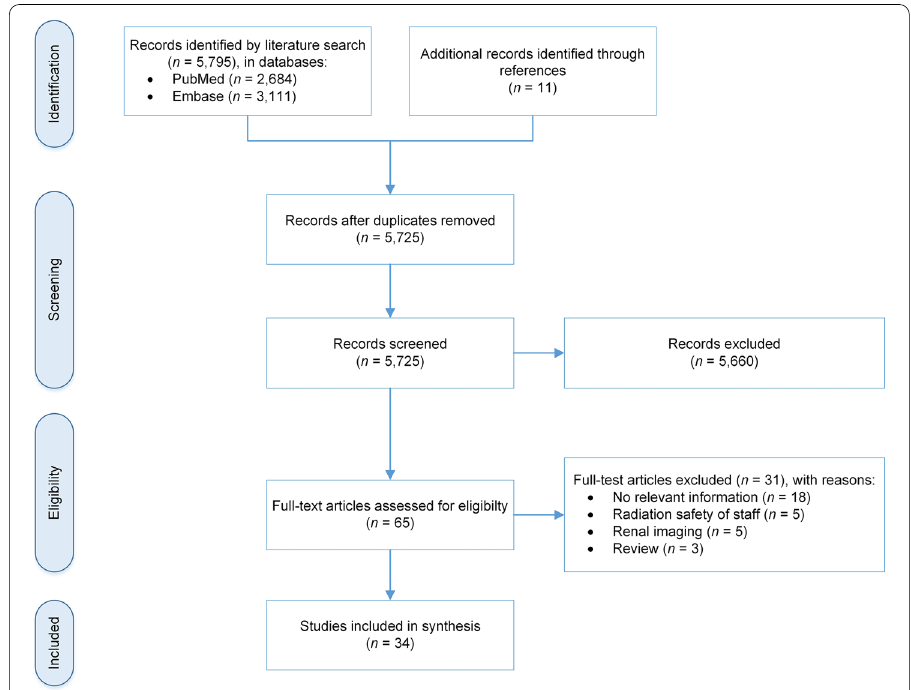
Fig. 1 Selection of studies according to the PRISMA statement (Moher et al.